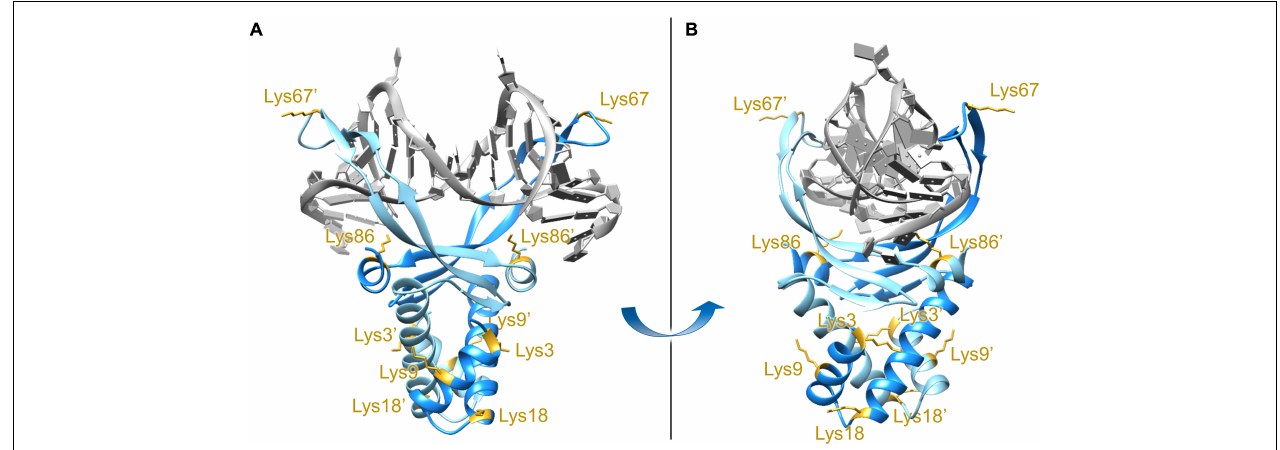
FIGURE 1 | Front view (A) and side view (B) of the DNA-bound E. coli HU β 2 homology model. The model was generated using SWISS-MODEL with the amino acid sequence of E. coli HU β 2 (Swiss-Prot/TrEMBL accession number P0ACF4) and PDB 1P51 ( Anabaena HU) as the template. Lysine residues at position 3, 9, 18, 67, and 86 have been reported to be acetylated in vivo (Castaño-Cerezo et al., 2014) and are annotated in the two subunits. Lys67 and Lys86, located in the DNA-binding β -ribbon arms and interface, respectively, were chosen for further